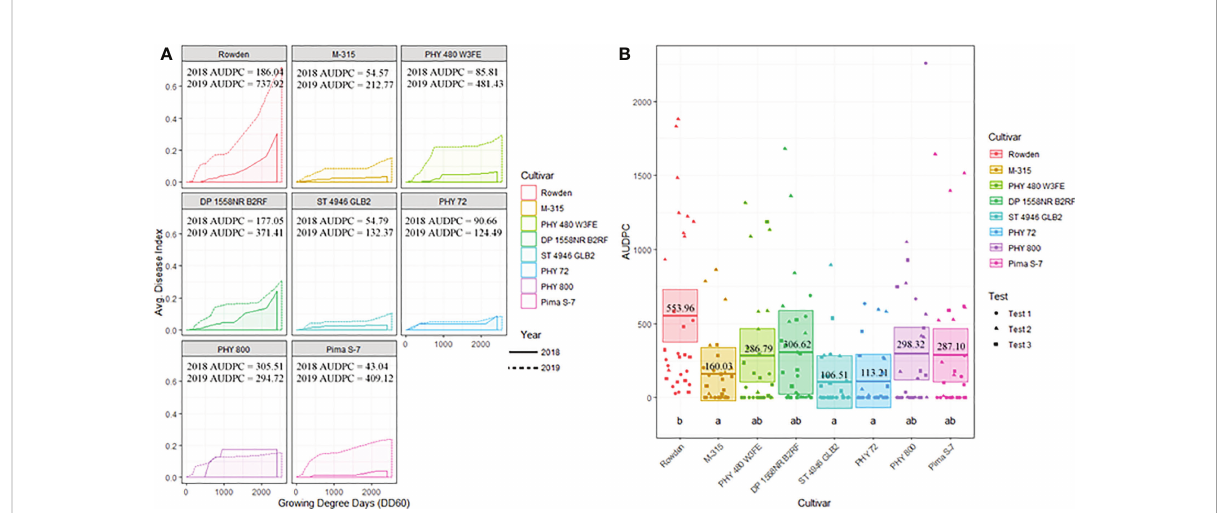
FIGURE 6 (A) Temporal disease progression curves for each cultivar included in the test to show the distribution throughout the cotton seasons demonstrated as a solid line for 2018 testing and a dashed line for 2019 testing. Area under the disease progress curve (AUDPC) is shaded in a lighter color as indicated by the legend. (B) Box plots means (indicated by thick horizontal lines) and 95% con fi dence intervals (shaded boxes) of the AUDPC values for each cotton cultivar as estimated by a linear mixed effect model shown as an average of all three test. Calculated AUDPC values for individual test plots are marked by symbols corresponding to the test from which they were collected. The mean AUDPC value is listed just above the mean line for each race/genotype of FOV and statistical signi fi cance is indicated by letters below the boxplots. Races/ genotypes that share signi fi cance letters do not differ signi fi